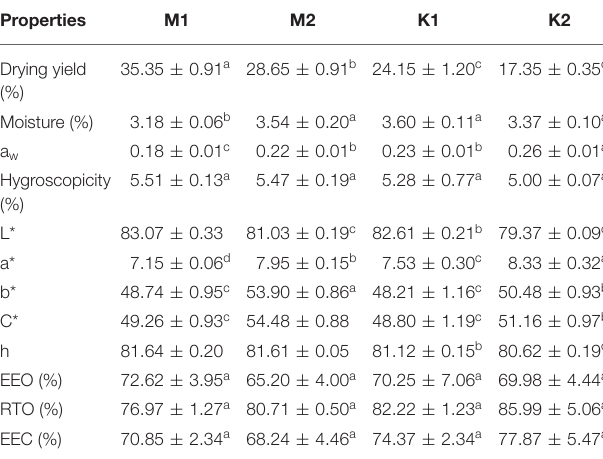
TABLE 4 | Physicochemical properties of buriti oil microcapsules.